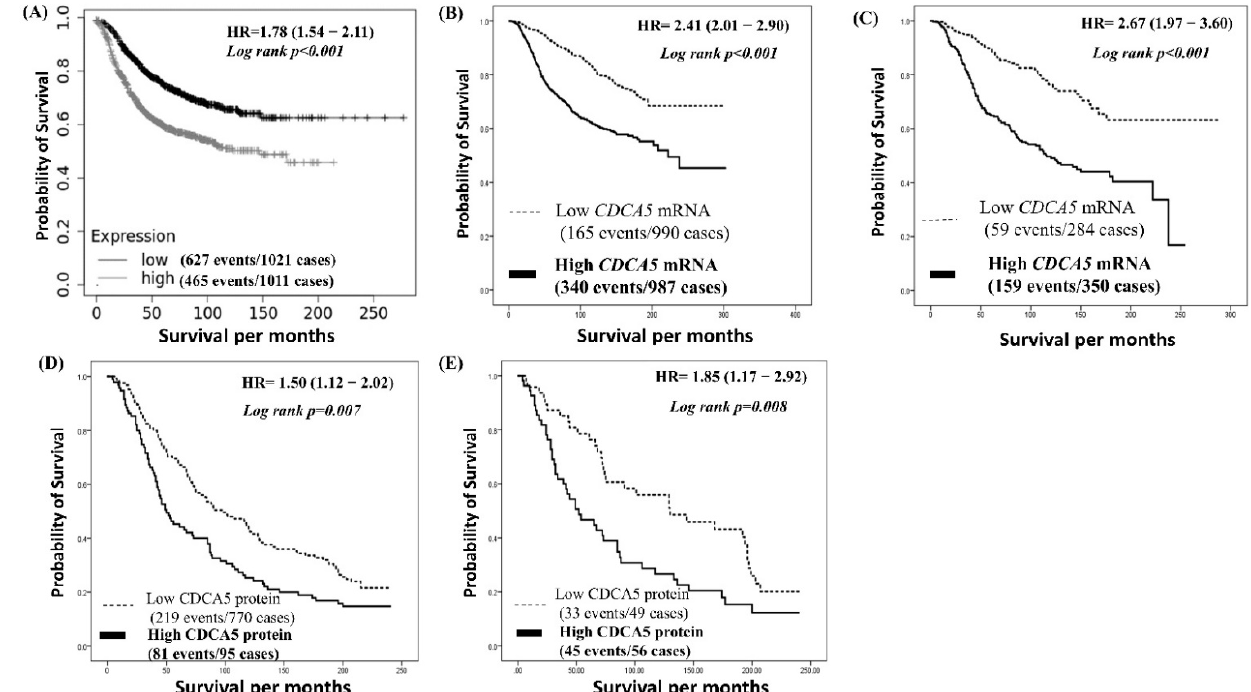
Figure 2. Patient outcomes of BC survival on the METABRIC and the Nottingham BC cohorts. ( A ) Cumulative survival of BC patients stratified by CDCA5 mRNA expression in the KM-Plotter cohort. ( B ) Cumulative survival of BC patients stratified by CDCA5 mRNA expression in breast tumors in METABRIC. ( C ) Cumulative survival of BC patients stratified by CDCA5 mRNA expression in LVI-positive BC in METABRIC. ( D ) Cumulative survival of BC stratified by CDCA5 protein expression. ( E ) Cumulative survival of BC patients stratified by CDCA5 protein expression in the Nottingham LVI-positive cohort.